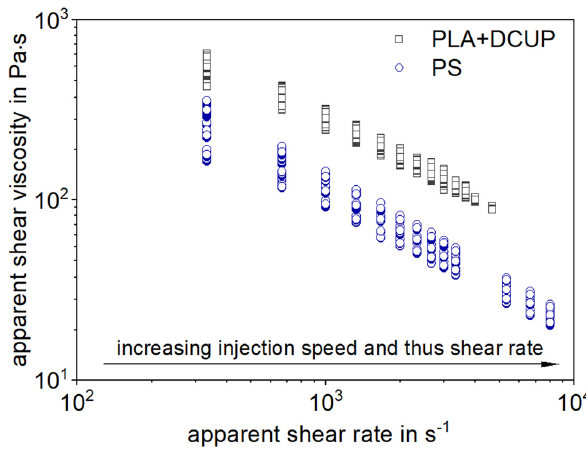
Figure 6: Calculated apparent viscosity for each injection speed in dependency of temperature, pressure, and blowing agent concentration.